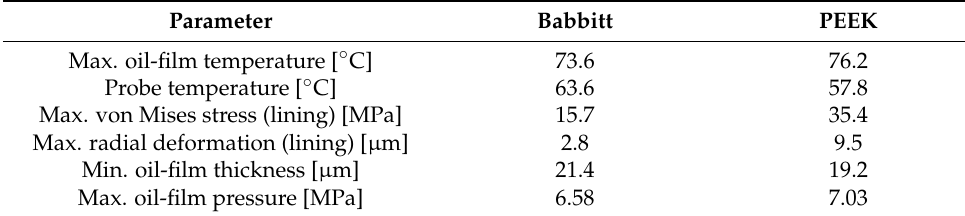
Figure 5. Pad deformation in nominal conditions: ( a ) Babbitt lining and ( b ) PEEK lining. Table 3. Results of simulation in nominal